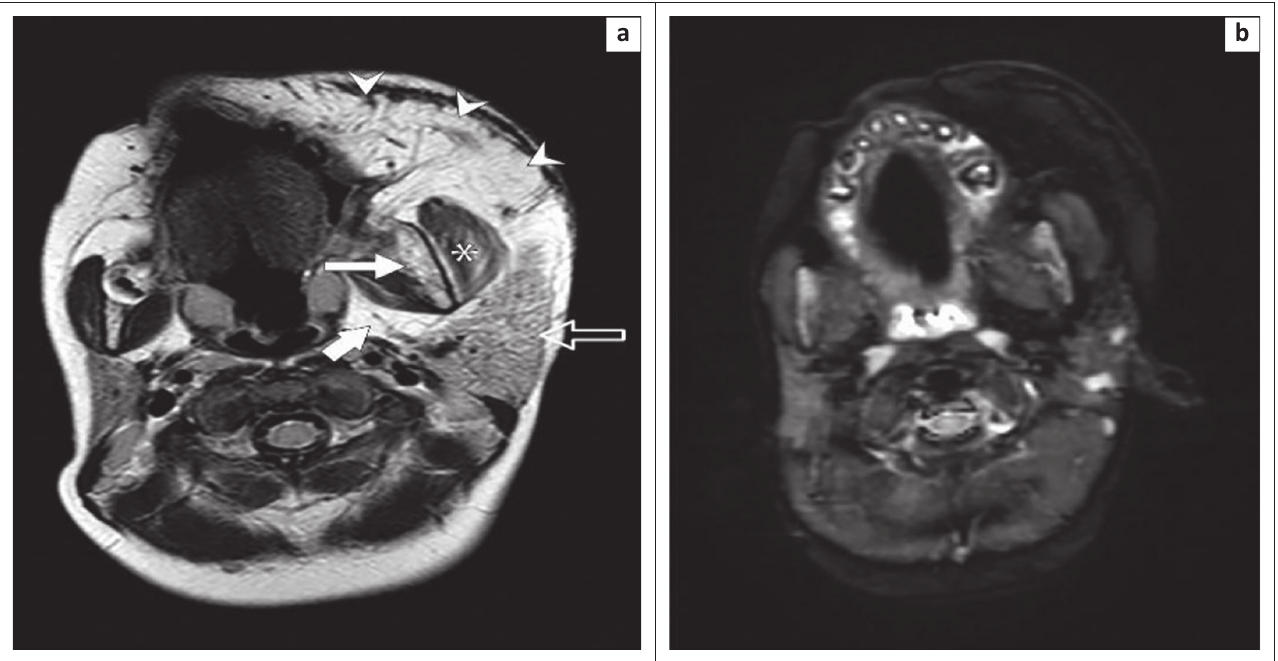
FIGURE 1: (a) Axial T2W MRI demonstrates an extensive, non-encapsulated left facial mass with fat signal (arrowheads) extending into the soft tissue spaces of the neck (short arrow) with associated hypertrophy of the left masseter muscle (asterisk) and parotid gland (open arrow). Mild hypertrophy of the left ramus of the mandible (long arrow) compared to the right can also be seen. (b) Axial fat suppressed image demonstrates complete suppression of signal within the lesion consistent with adipose tissue.